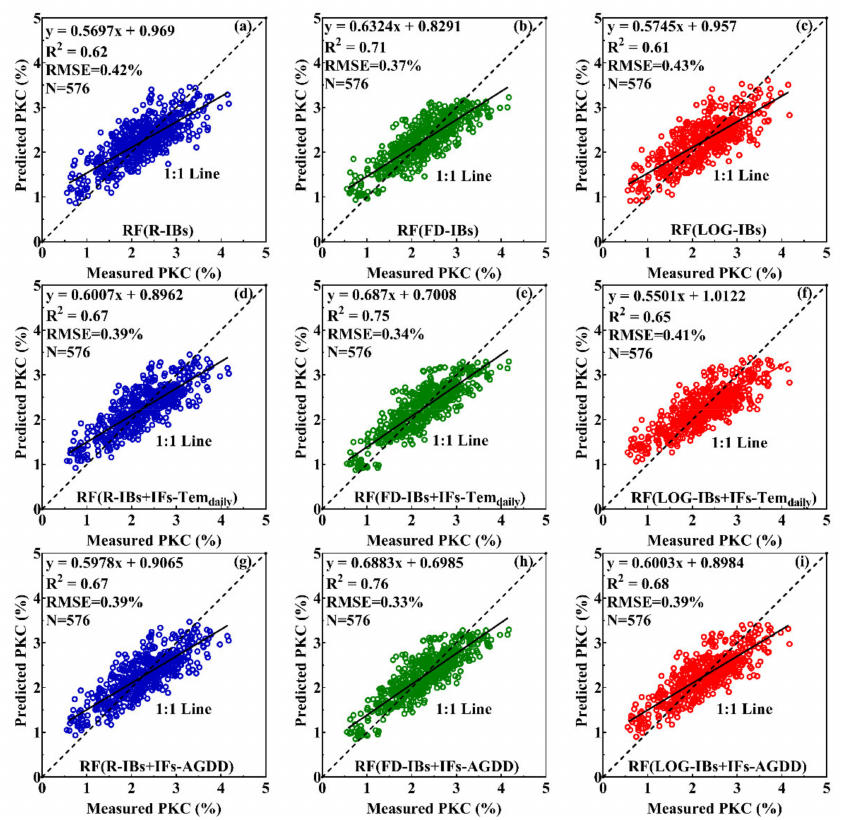
Figure 9. Relationships between the measured plant potassium content (PKC) and predicted PKC with the calibration dataset using random forest (RF) based on important bands (Ibs) of reflectance spectra (R-Ibs) ( a ), Ibs of first derivative spectra (FD-Ibs) ( b ), Ibs of reciprocal logarithm-transformed spectra (LOG-Ibs) ( c ), R-Ibs + important meteorological factors (Ifs) including daily average tem- perature and humidity (Ifs-Tem daily ) (R-Ibs + Ifs-Tem daily ) ( d ), FD-Ibs + Ifs-Tem daily ( e ), LOG-IBs + IFs-Tem daily ( f ), R-IBs + IFs including accumulated growing degree day (AGDD) and daily average humidity (IFs-AGDD) (R-IBs + IF-AGDD) ( g ), FD-IBs + IFs-AGDD ( h ), and LOG-IBs + IFs-AGDD ( i